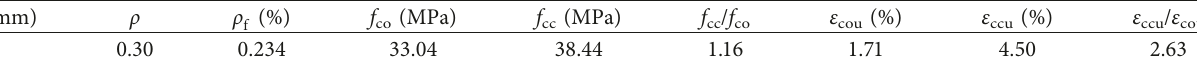
Table 2: Details and experimental key results by Rousakis et al. [32] for FE model calibration.